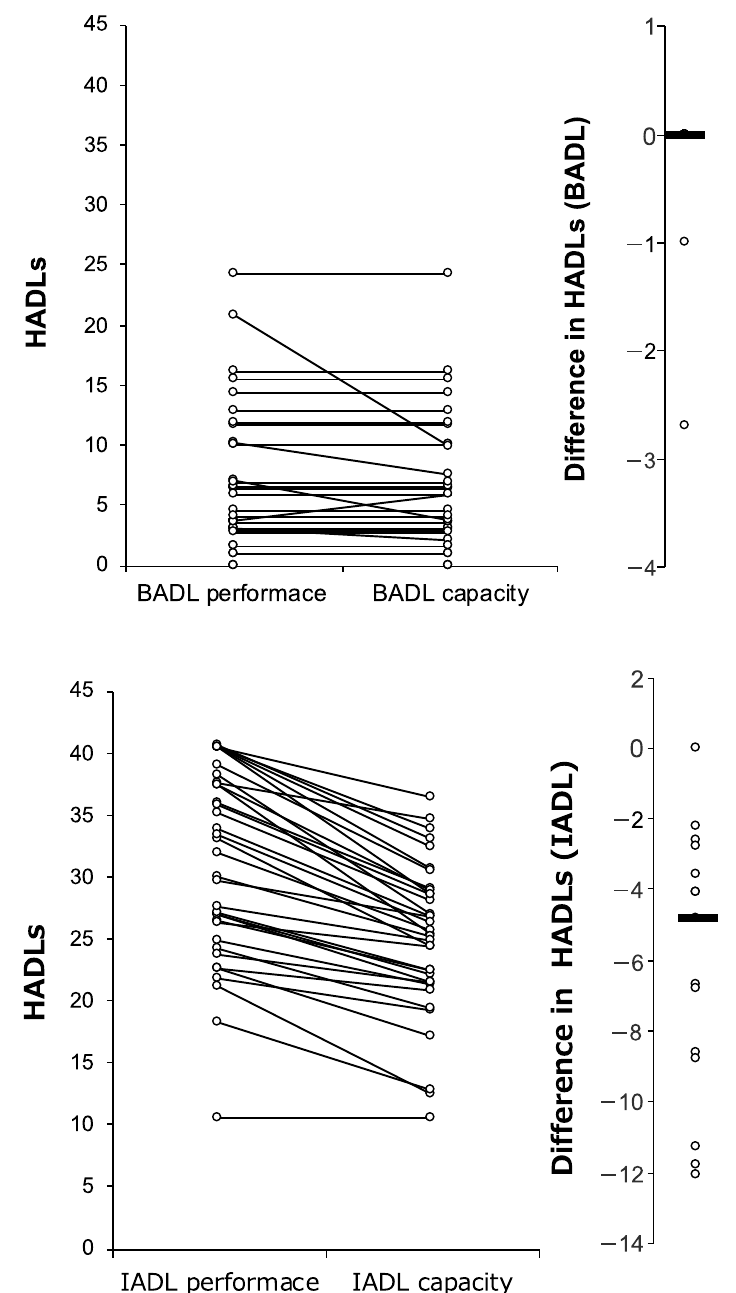
Figure 1. Comparisons of ADL performance versus capability for BADL and IADL as rated using the HADLS. Higher HADLS values signify lower levels of independence. The black line shows the change in performance and capacity of ADL for the same participant. The second vertical axis of the graph represented the distribution of the difference between ADL performance and ADL capacity. The bold line represents the median.